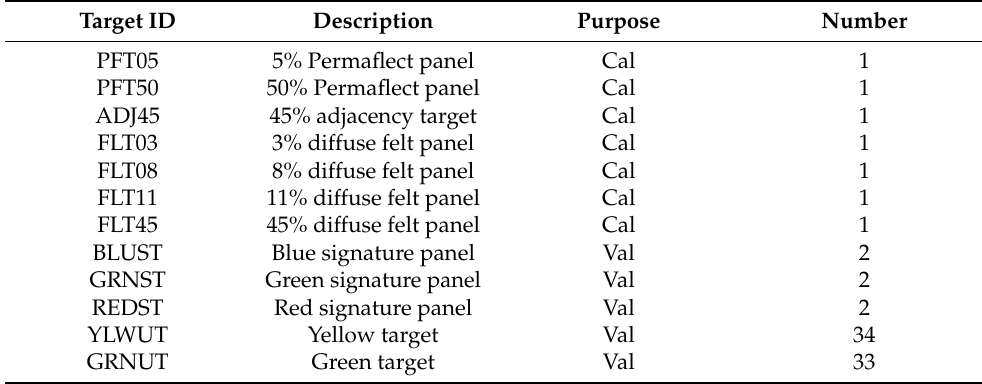
Figure 4. Permaflect ® reflectance standards. 50% reflectance standard ( top ) and 5% standard ( middle ) with lab measured reflectance factor ( right ). A green target detection panel is visible between the targets ( bottom ). Table 1. Diffuse reflectance target IDs, descriptions, and